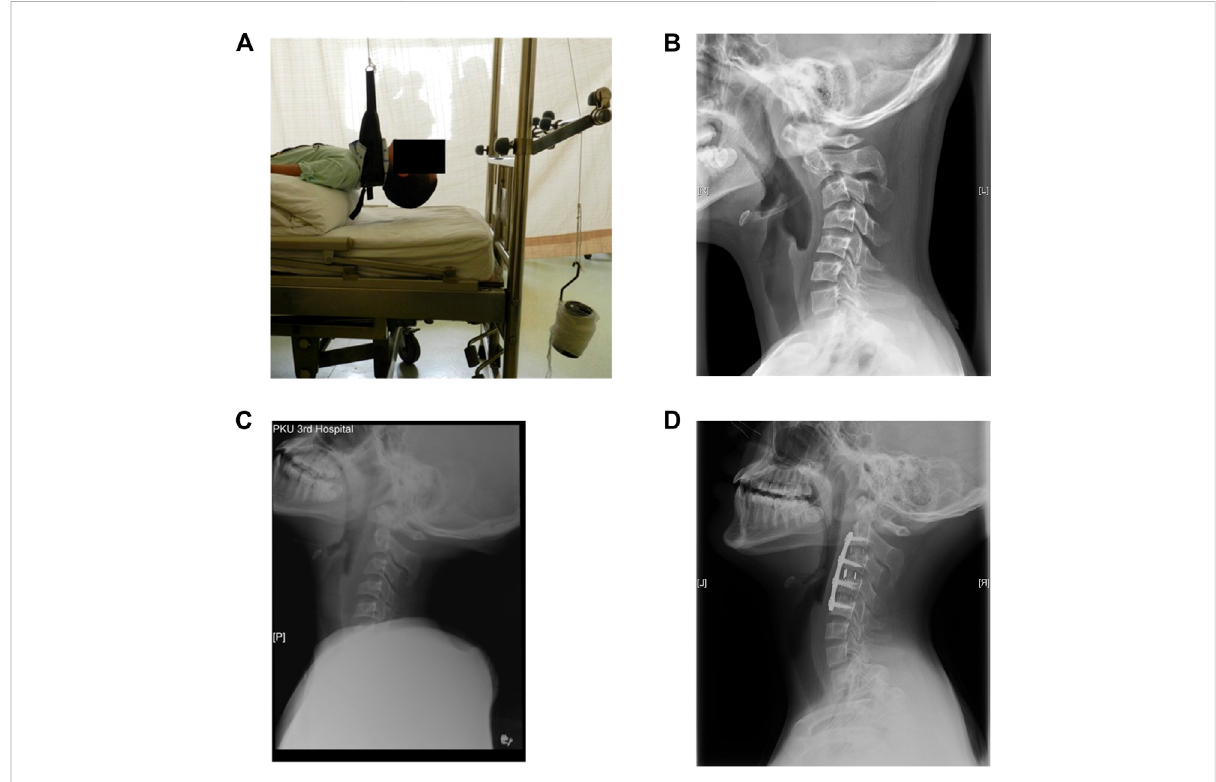
FIGURE 1 (A) Photo of the preoperative moment-balanced traction, (B) lateral view of preoperative cervical X-ray, C2 – C5 Cobb angle was − 53.2 ° , (C) X- ray after the moment-balanced traction, (D) lateral view of cervical spine at three-month follow-up, Cobb angle of C2 – C5 was − 3.3 ° .